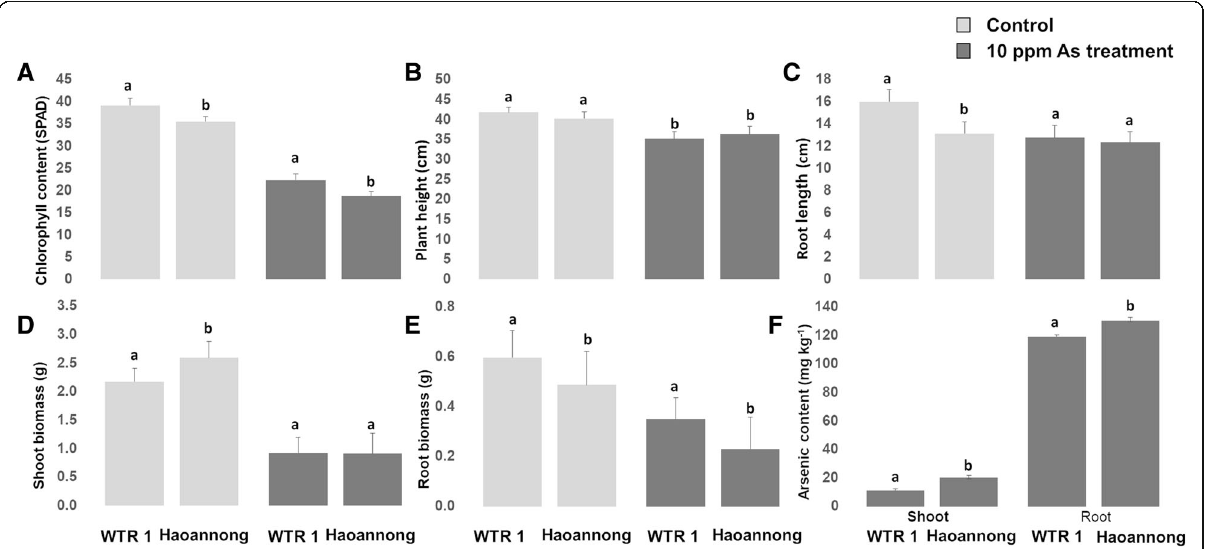
Fig. 1 Phenotypic trait variation in parents of mapping population under As toxicity stress for 18 days. (A) Chlorophyll content; (B) plant height; (C) root length; (D) shoot dry weight; (E) root dry weight; (F) arsenic content in shoot and root tissue. Vertical bars represent standard errors of means ( n = 3). Different letters above the data points indicate significant differences between genotypes by LSD test ( P <